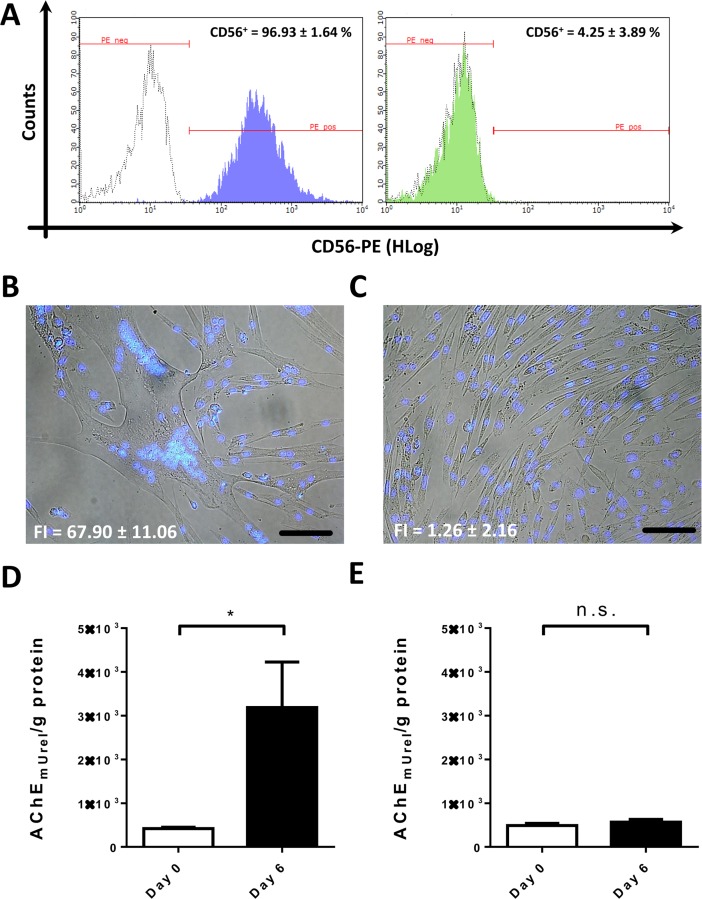
SMDC isolation, differentiation and AChE quantification.CD56+ and CD56- cells were separated by MACS. Successful separation was confirmed by flow cytometry. Positively selected cells from five different human muscle biopsies using anti CD56 MACS antibody contain 96.93 ± 1.64% CD56+ cells (representative histogram in purple) whereas negatively selected cells from five individual patients contain 4.25 ± 3.89% CD56+ cells (representative histogram in green). White histograms represent isotype control staining (A). When cultured in skeletal muscle differentiation medium, single nucleated CD56+ SMDCs fuse and produce multinucleated tubes on gelatin coated 24-well plates with a fusion index (FI) of 67.90 ± 11.06 (mean ± SD; n = 3) after 6 days of differentiation (B). CD56- SMDCs do not form myotubes within 6 days of cultivation in differentiation medium on gelatin coated 24-well plates (FI = 1.26 ± 2.16, n = 3) (C). The change in AChE activity per g total protein of 200 000 CD56+ cells seeded on gelatin-coated 24-well plates before induction of differentiation (Day 0) and 6 days after differentiation (Day 6) is significantly different (p<0.05) in a ratio paired t-test of at least three patient samples (data presented as mean ± SEM) (D) but not significantly (n.s.) different between AChE activity in three batches of CD56- cells before and 6 days after induction of skeletal muscle differentiation in a ratio paired t-test of three different SMDC patient samples (E). Scale bar (white) = 100 μm.